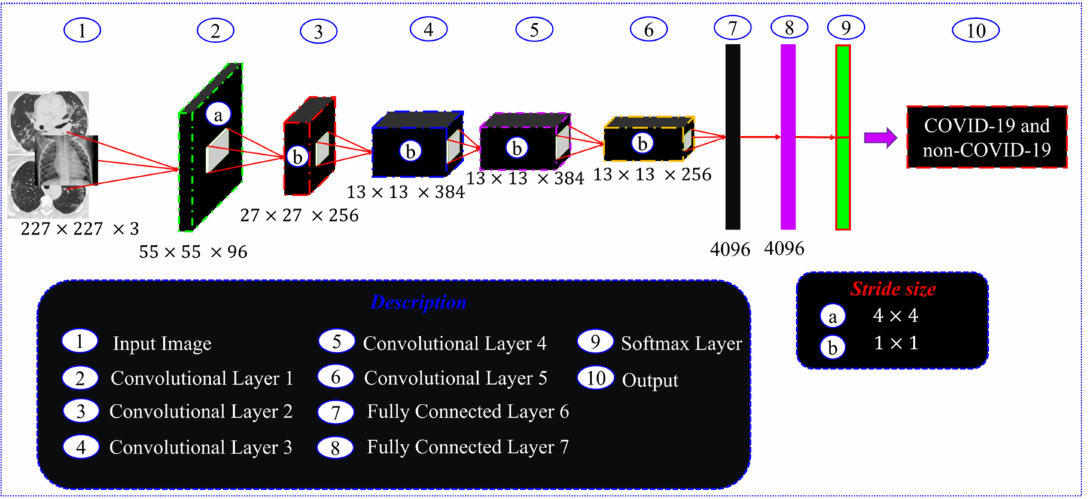
Figure 5. Detection of COVID-19 with